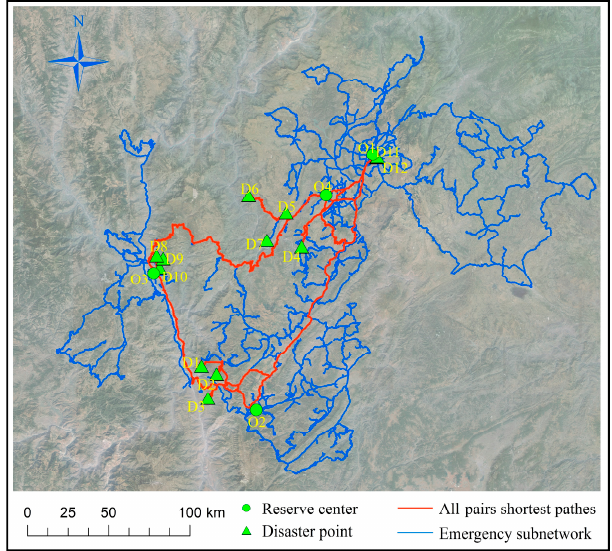
Figure 5. The emergency transportation network for the Ludian earthquake in 2014. Table 2. The road attributes in an earthquake disaster